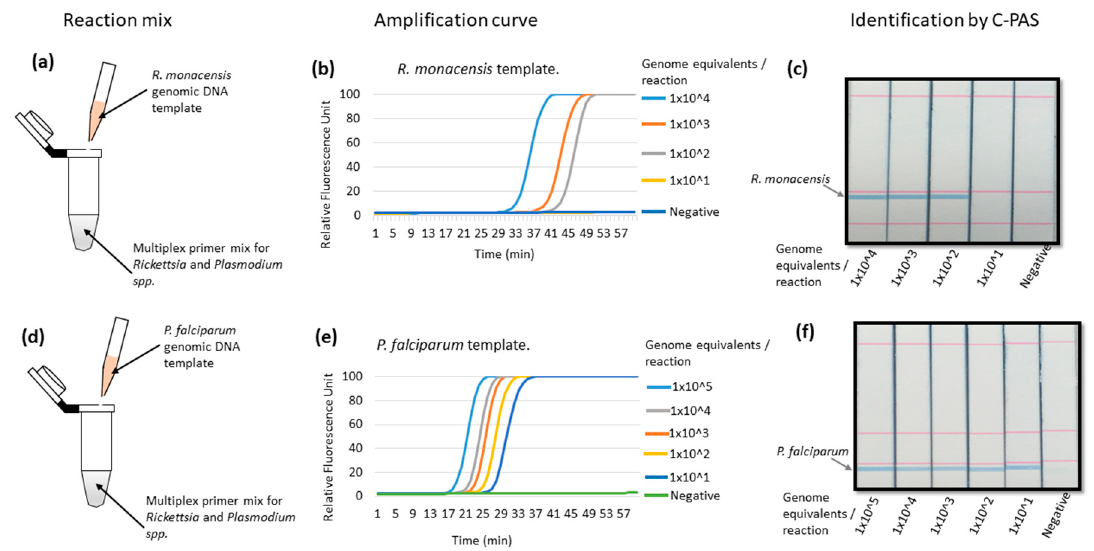
Figure 3. Multiplex LAMP amplification using genomic DNA from in vitro cultured organisms. ( a ) shows the multiplex LAMP primer sets with R. monacensis genomic DNA in the reaction mix. The amplification curve shows detection up to 100 genome equivalents per reaction of R. monacensis ( b ) and identification of amplicons as Rickettsia by C-PAS ( c ). The reaction mix contained multiplex LAMP primer sets with P. falciparum genomic DNA ( d ). ( e ) shows the amplification curve of P. falciparum detecting up to 10 genome equivalents per reaction. C-PAS identified the amplified product as Plasmodium ( f ).